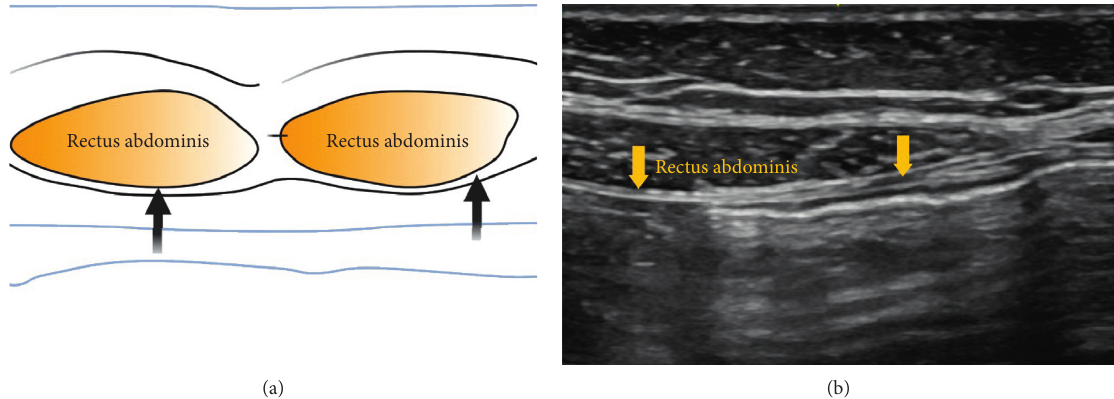
Figure 3: Black and yellow arrows indicate the point of local anesthetic